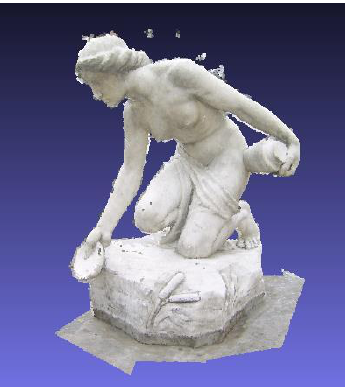
Figure 16.3D modeling of The Rebeca.